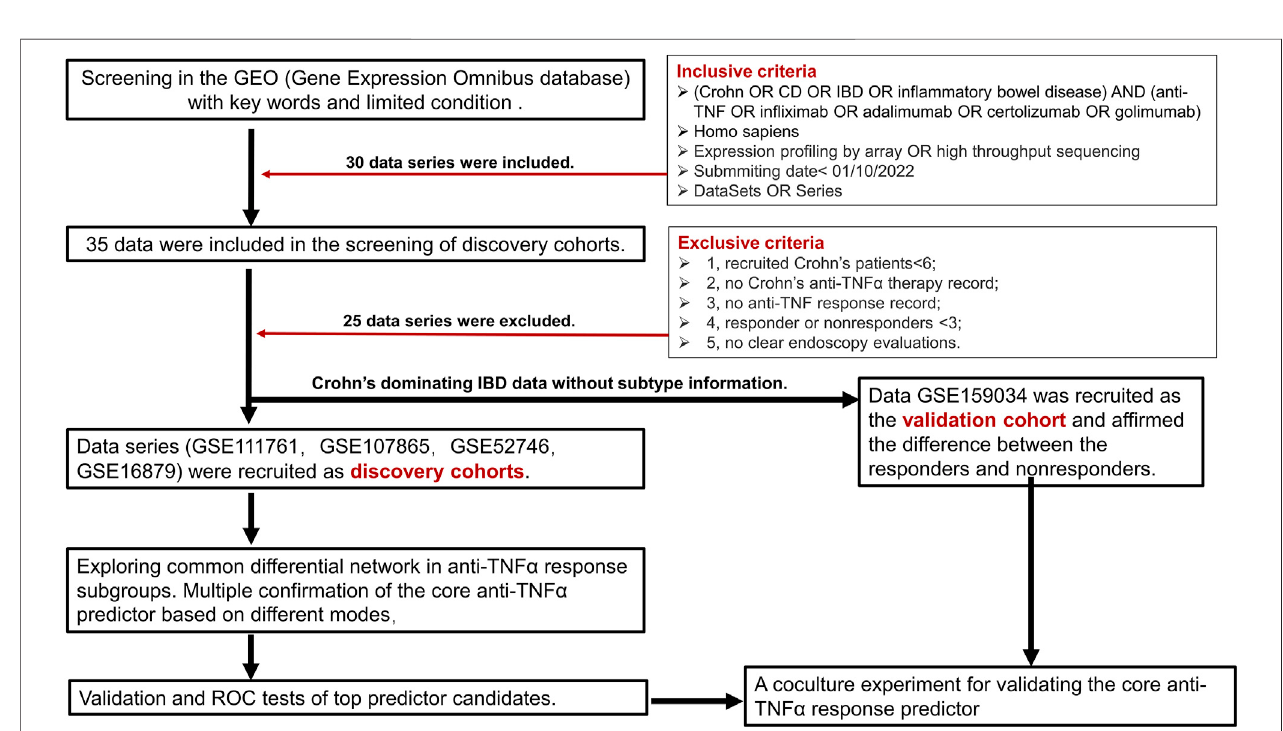
FIGURE 1 | Detailed data preparation fl ow of the